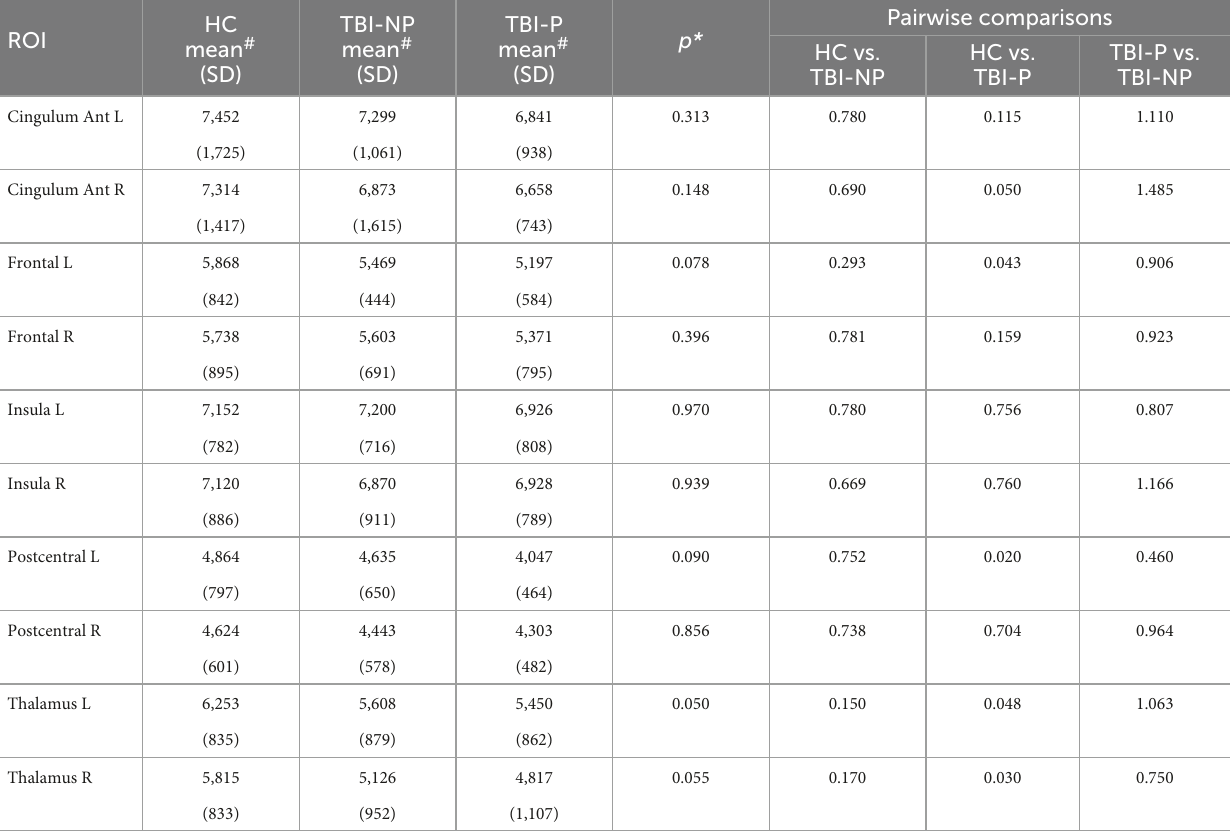
TABLE 5 Results from analysis of covariance (ANCOVA) controlling for age between HC ( N = 31), TBI-NP ( N = 17) and TBI-P ( N = 16) groups for total choline (tCho).